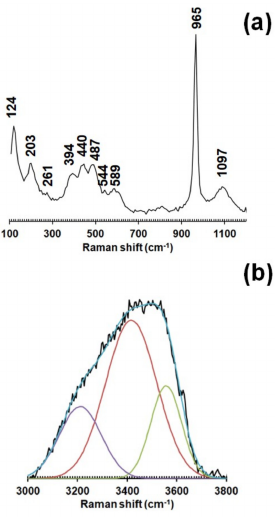
Figure 2. Micro-Raman spectrum of tiberiobardiite in the spectral range 100–1200 cm − 1 ( a ) and 3000–4000 cm − 1 ( b ). In ( b ), the components contributing to the broad band are